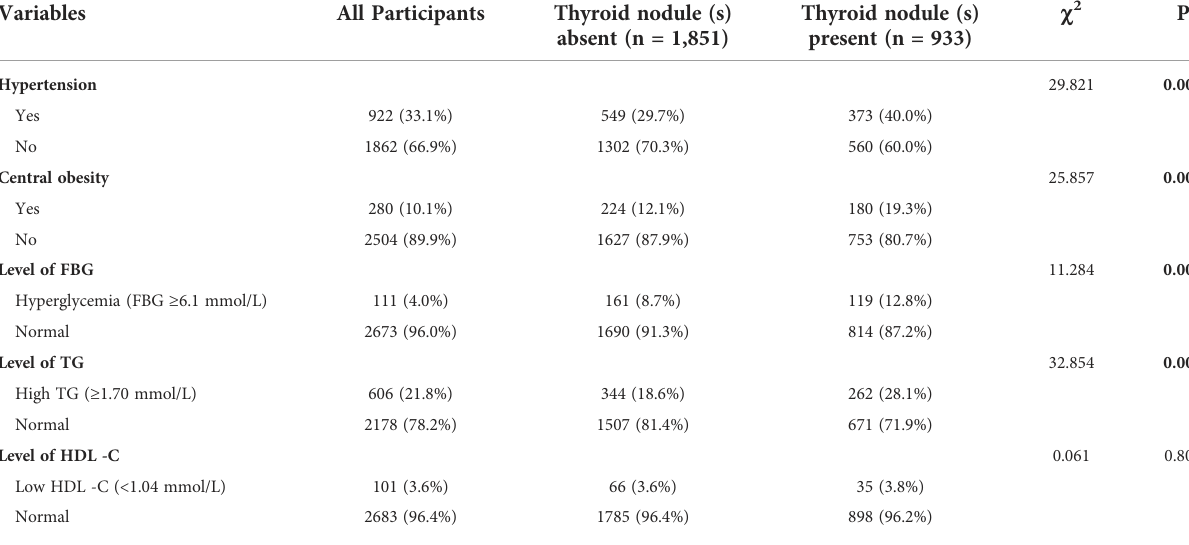
pvalueswerefromthechi-squaretestforcategoricalvariables;Categoricalvariablesarepresentedasnumber(percentage);Hypertension:bloodpressure ≥ 130/85mmHgand/ordiagnosed hypertension;Abdominalobesity:femalewaistcircumference ≥ 85cm;Hyperglycemia(FBG ≥ 6.1mmol/L).FBG,fastingbloodglucose;TG,triglyceride;HDL-C,High-densitylipoprotein cholesterol; LDL -C, Low-density lipoprotein cholesterol. Bold means, P values are statistically signi fi